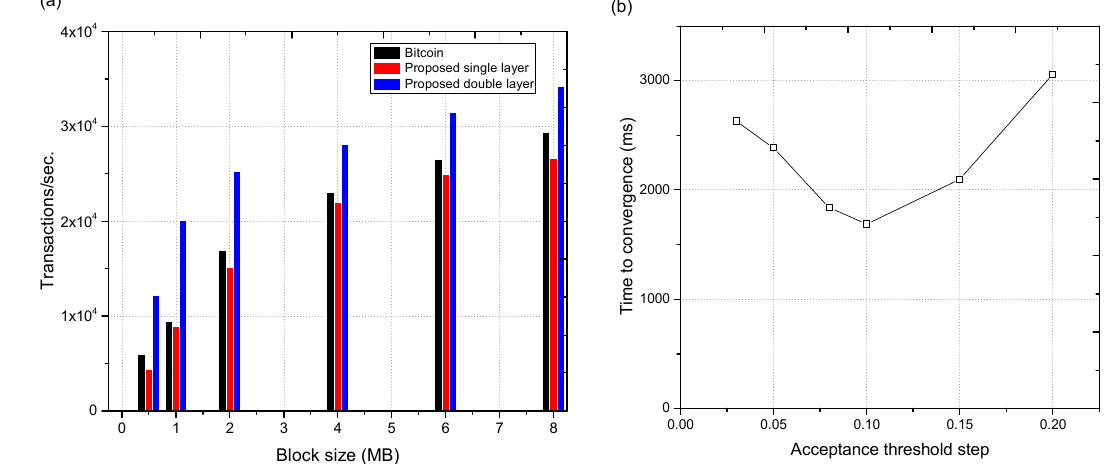
Figure 6. ( a ) Block size against transactions/s of proposed blockchain architecture in comparison with bitcoin and the proposed single layer architecture, and ( b ) convergence time of proposed blockchain architecture against acceptance step δ .